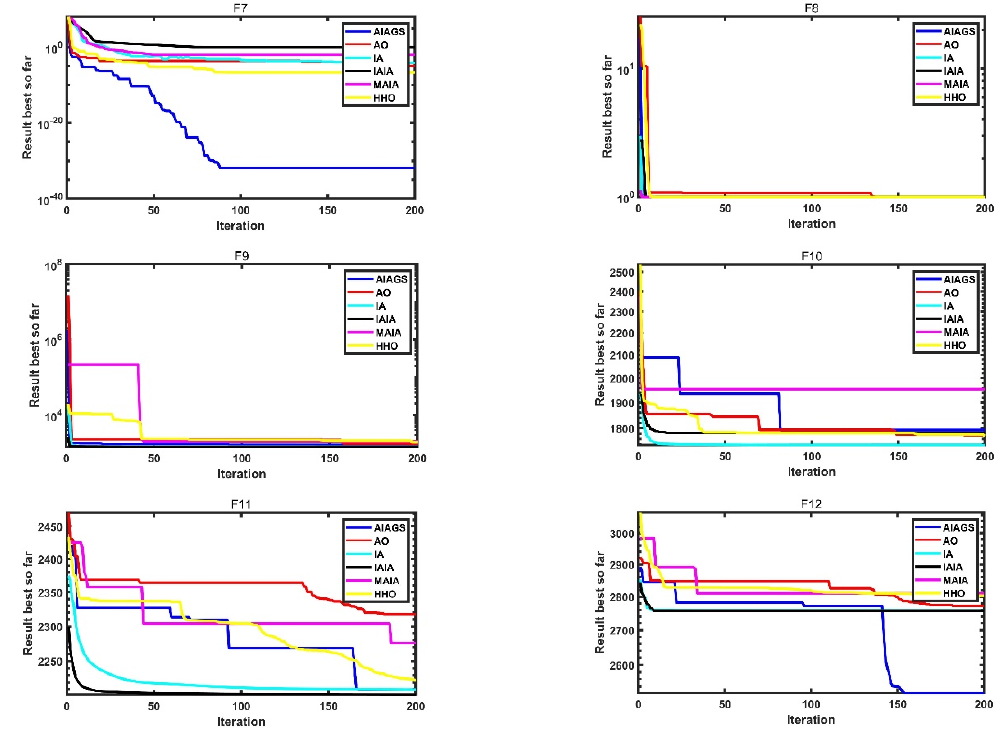
Figure 3. The convergence curves of AIAGS and other six algorithms.